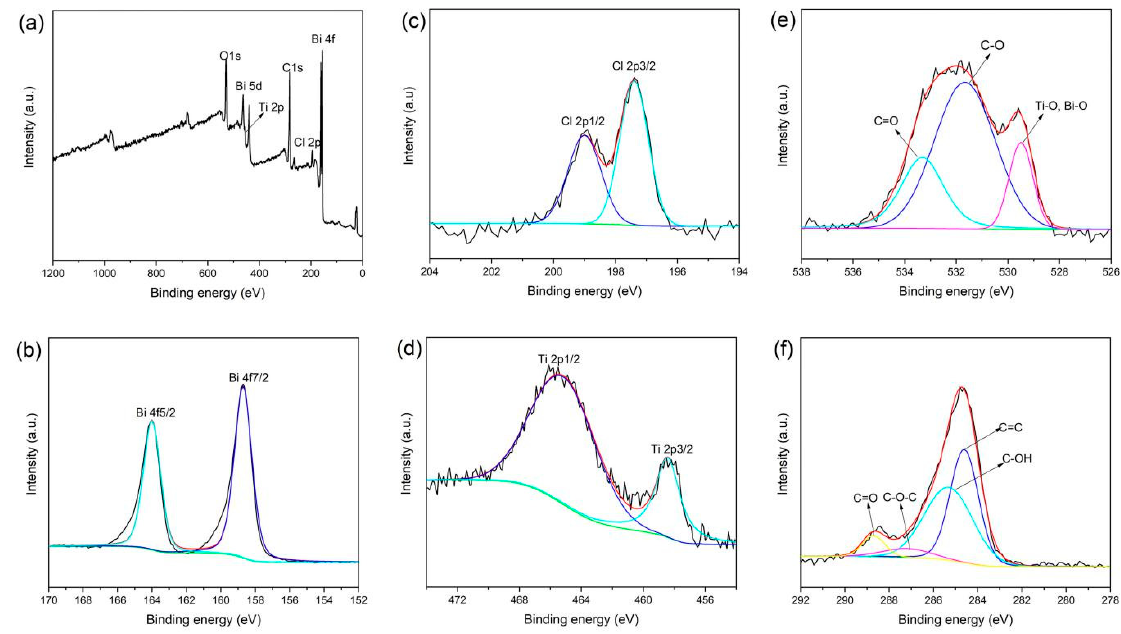
Figure 2. ( a ) XPS wide scan spectrum of RGO / BiOCl / TiO 2 nanocomposites; ( b – f ) XPS high resolution spectra of RGO / BiOCl / TiO 2 nanocomposites: ( b ) Bi 4f, ( c ) Cl 2p, ( d ) Ti 2p, ( e ) O1s, and ( f ) C 1s